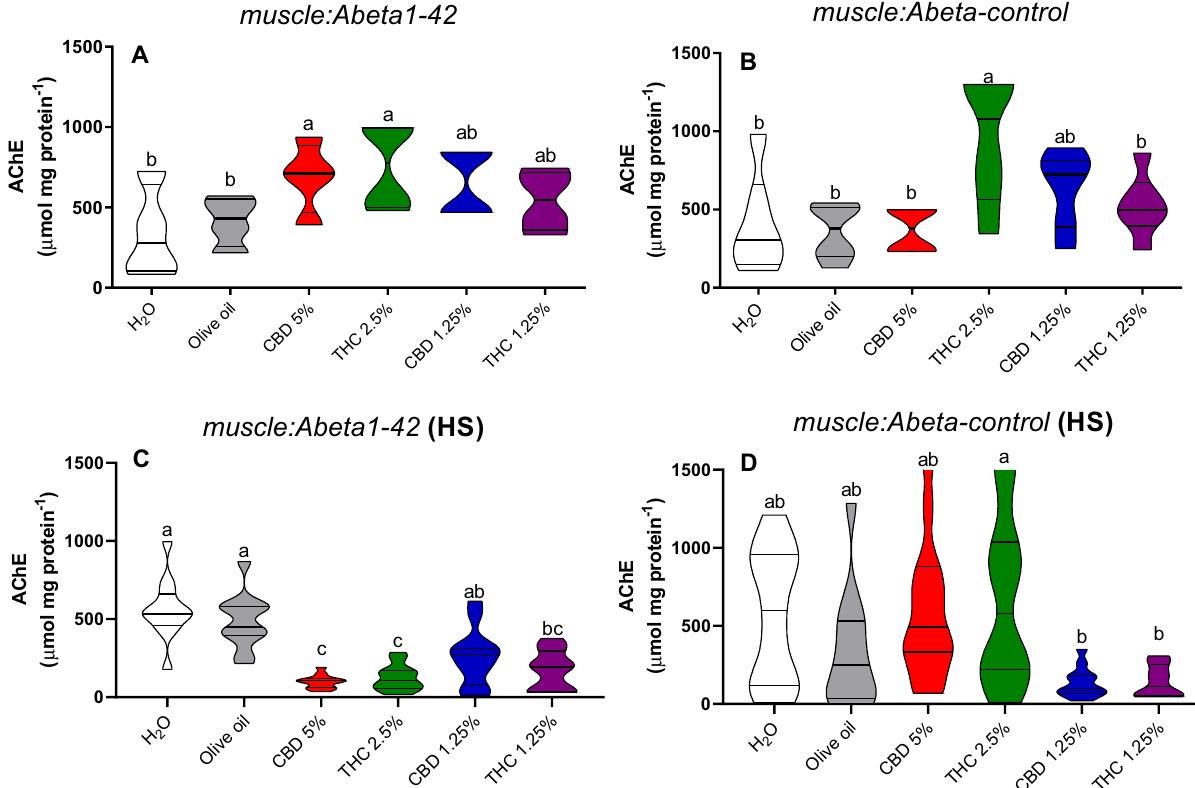
Figure 8. Acetylcholinesterase (AChE) activity in non-stressed ( A , B ) and heat-stressed (HS) ( C , D ) C. elegans muscle:Abeta1-42 and muscle:Abeta-control transgenic strains. Data are expressed by the mean ± standard error (SEM). Means followed by the same letter are not significantly different according to Tukey’s test ( p > 0.05) ( A , B ) or Dunn’s test ( p > 0.05) ( C , D